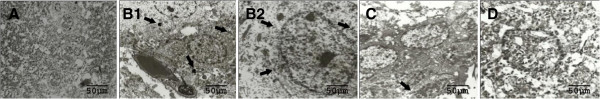
Transmission electron microscopic appearance of striatum. A: Control (group1); B1: low resolution of MPTP induced (group II); B2: high resolution of MPTP induced (group II); C: MPTP induced + As treated (group III); D: Drug Control (group IV).